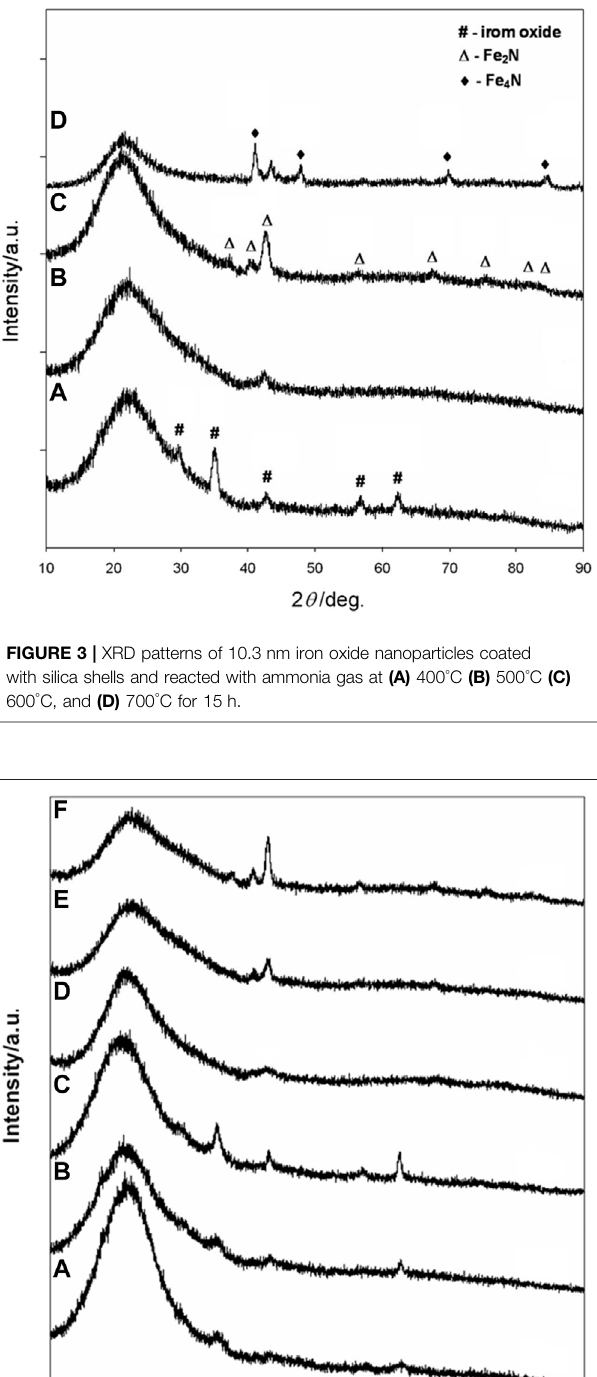
Frontiers in Bioengineering and Biotechnology |